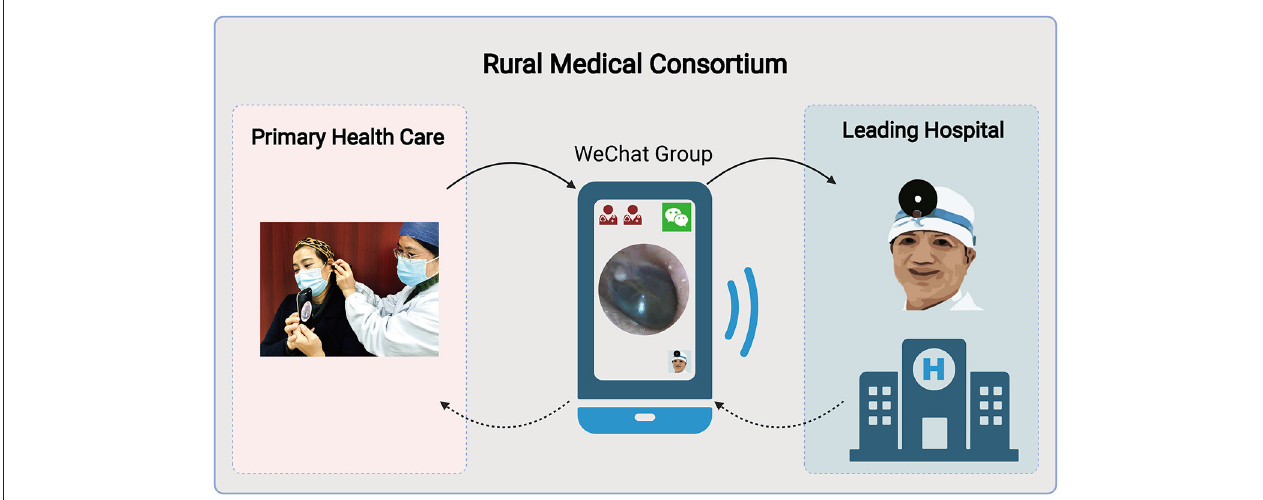
FIGURE 1 | Flowchart of WeChat-based smartphone otoscope telemedicine within a rural medical consortium. The flowchart was created with BioRender.com.